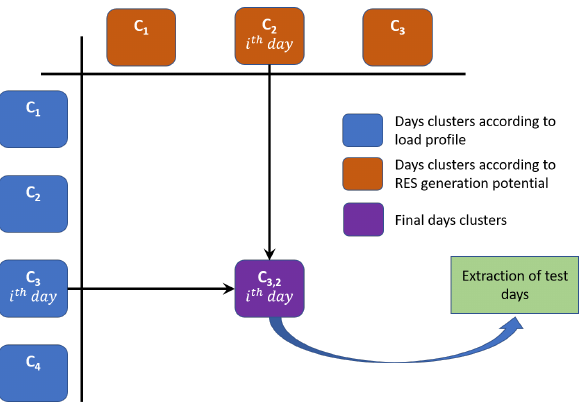
Figure 5. Clusterization procedure of demand and load